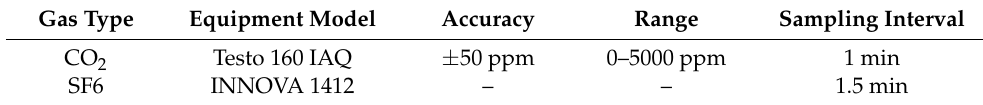
Table 4. The sensor